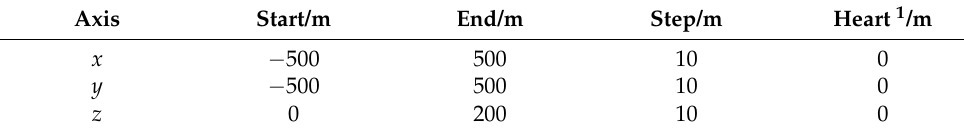
Table 2. Data simulation point coordinate parameters.